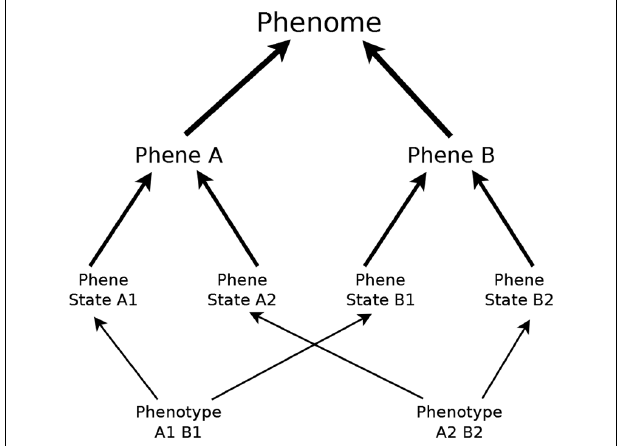
FIGURE 1 | Studying the characteristics of phenotypes of different individuals allows us to identify phenes and their existent states. The phenome is the total possible phenotypic potential of a taxon, including all possible phene states.The phenotypes presented here do not represent all possible phenotypes of this